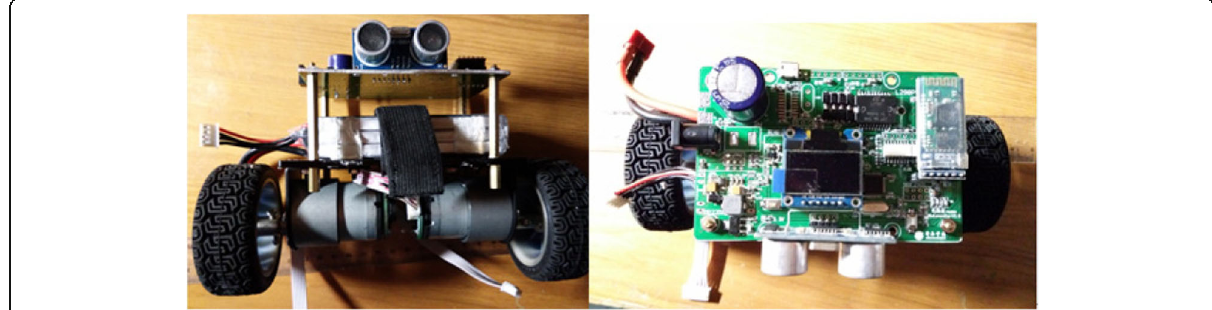
Fig. 35 The overall assembly diagram